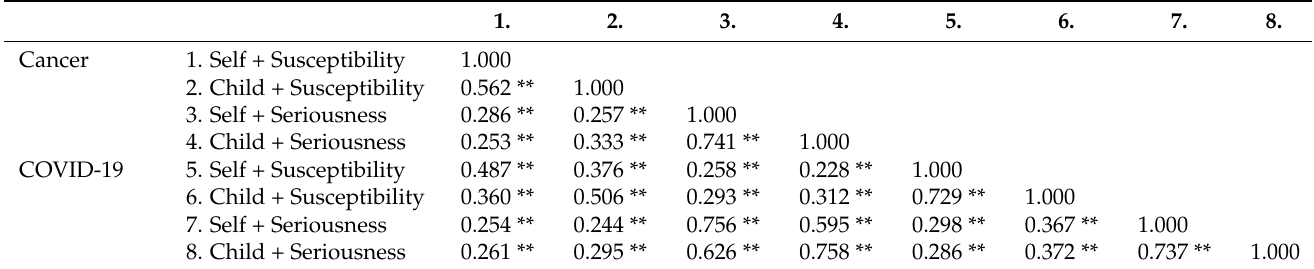
Table 3. Correlation of susceptibility and seriousness toward cancer and COVID-19.